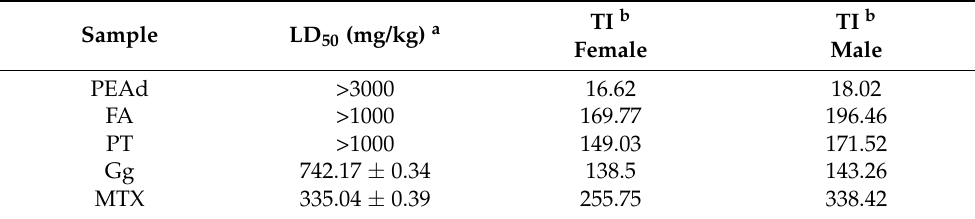
Table 6. Acute oral toxicity from petroleum ether extract and its terpenoids geranylgeraniol (Gg), phytol (PT), and farnesyl acetate (FA) obtained of the leaves from A. macroprophyllata leaves. Sample